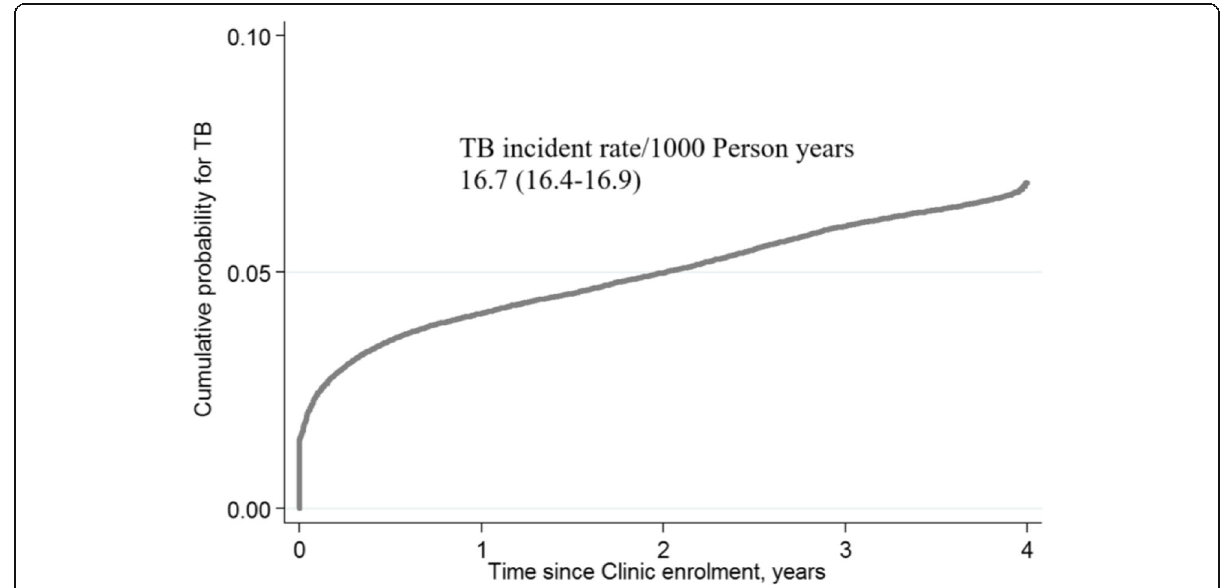
Fig. 1 Cumulative probability of TB incident after enrollment to HIV care and treatment